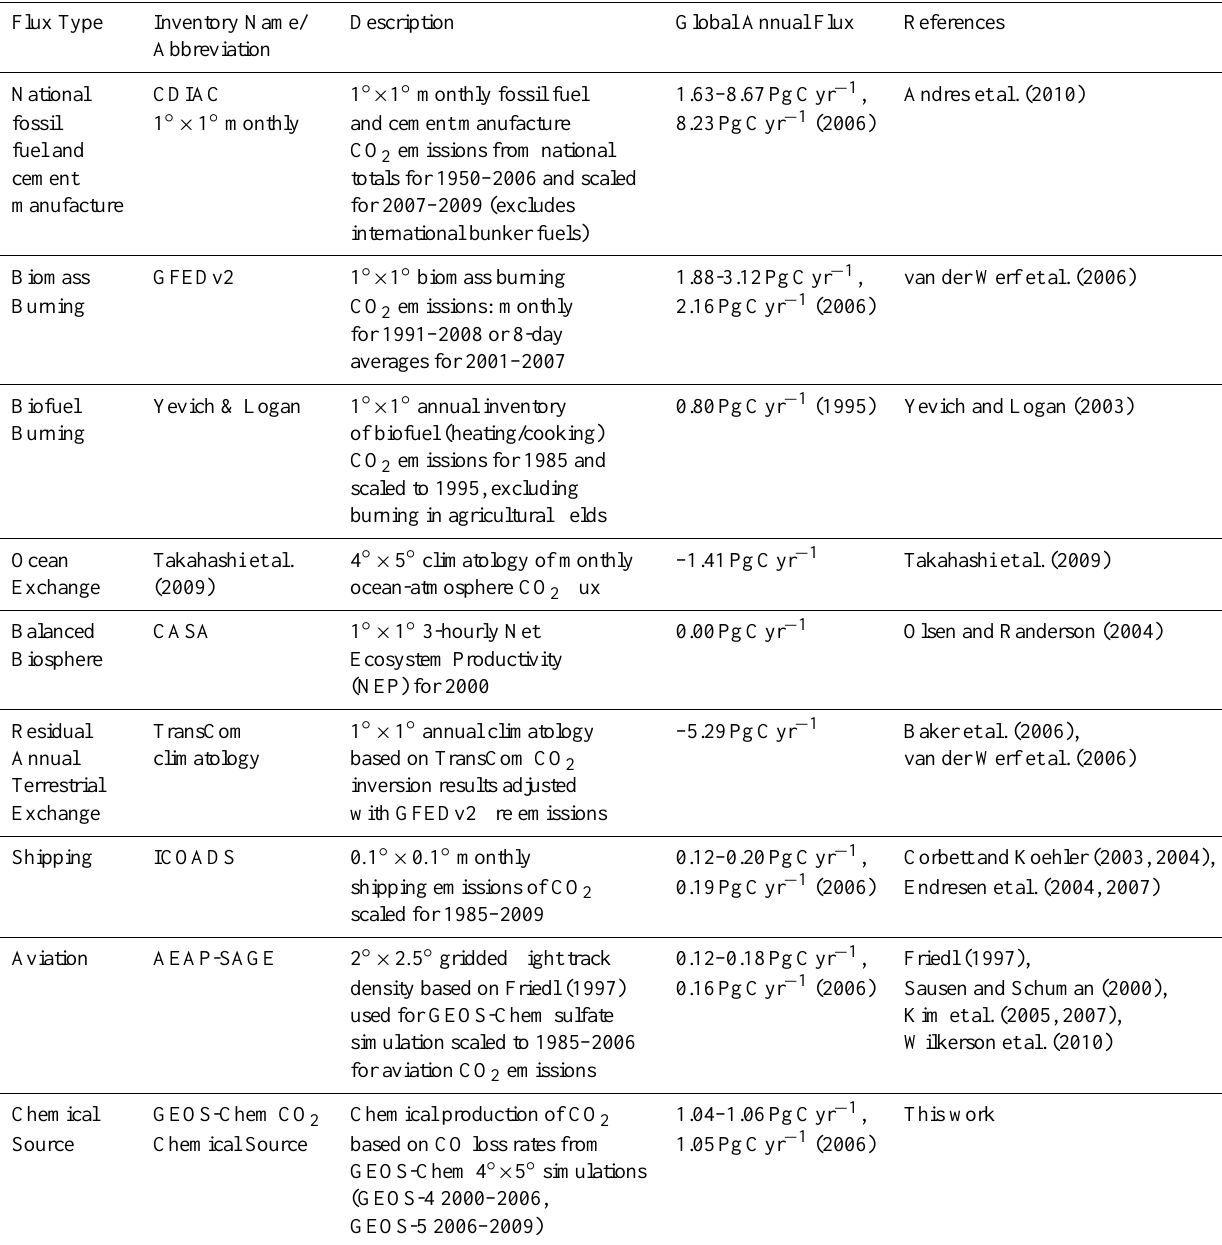
Table 1. Summary of key inventories for GEOS-Chem CO 2 simulations in this work along with global total values in PgCyr − 1 for one or more simulation